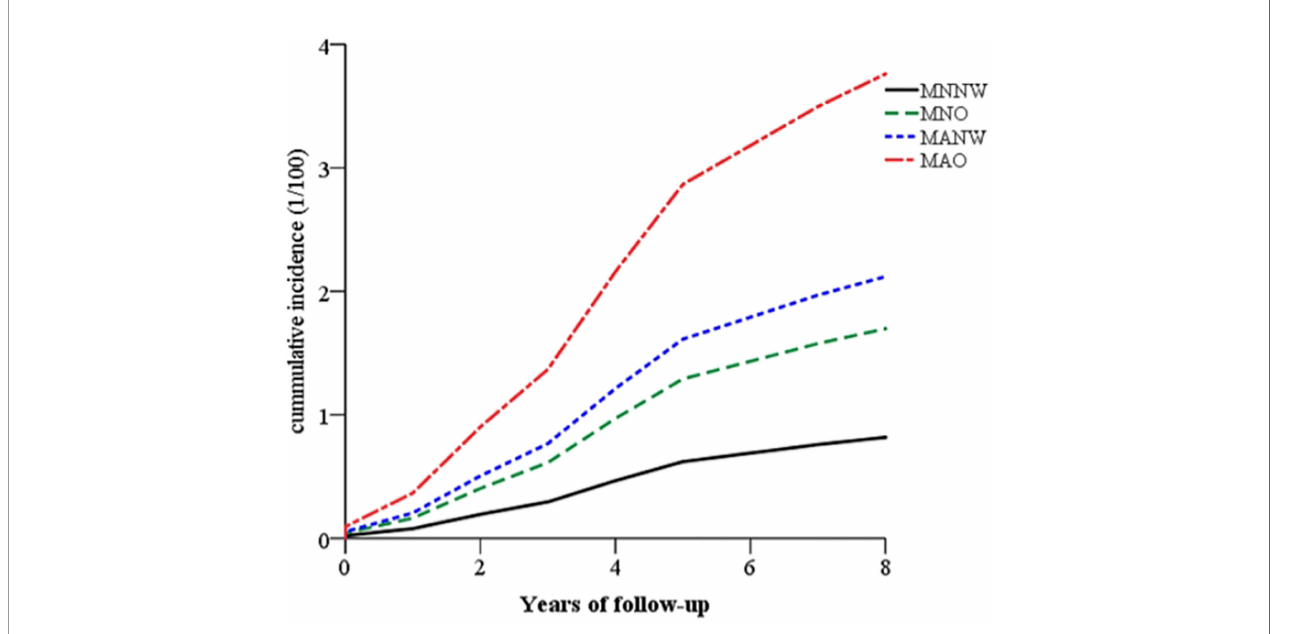
FIGURE 1 | The overall trends of the cumulative incidence of T2DM in the subjects with different phenotypes of obesity after follow-up in the Zhejiang cohort. The subjects with MAO (red and solid line) had the highest incidence of T2DM, followed by MANW (blue and dotted line) and MNO (green and dashed line). MNNW (black and dashed-dotted line) had a lower risk. T2DM, type 2 diabetes mellitus; MAO, metabolically abnormal and obesity/overweight; MANW, metabolically abnormal but normal weight; MNO, metabolically normal but obesity/overweight; MNNW, metabolically normal and normal